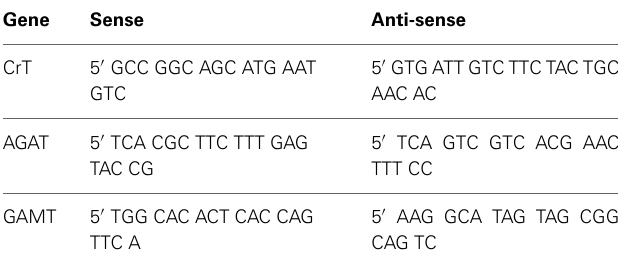
Table 1 | Sequence of forward and reverse primers for genes of